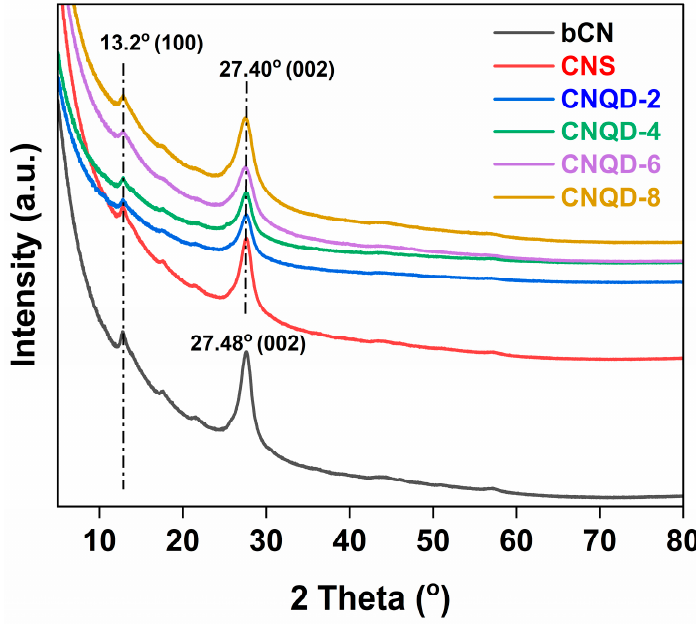
Figure 5. XRD patterns of bCN, CNS, and CNQD